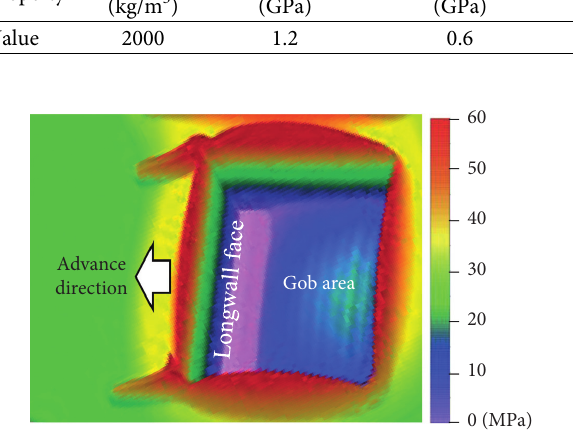
Figure 8: Spatial distribution of the vertical stress in panel